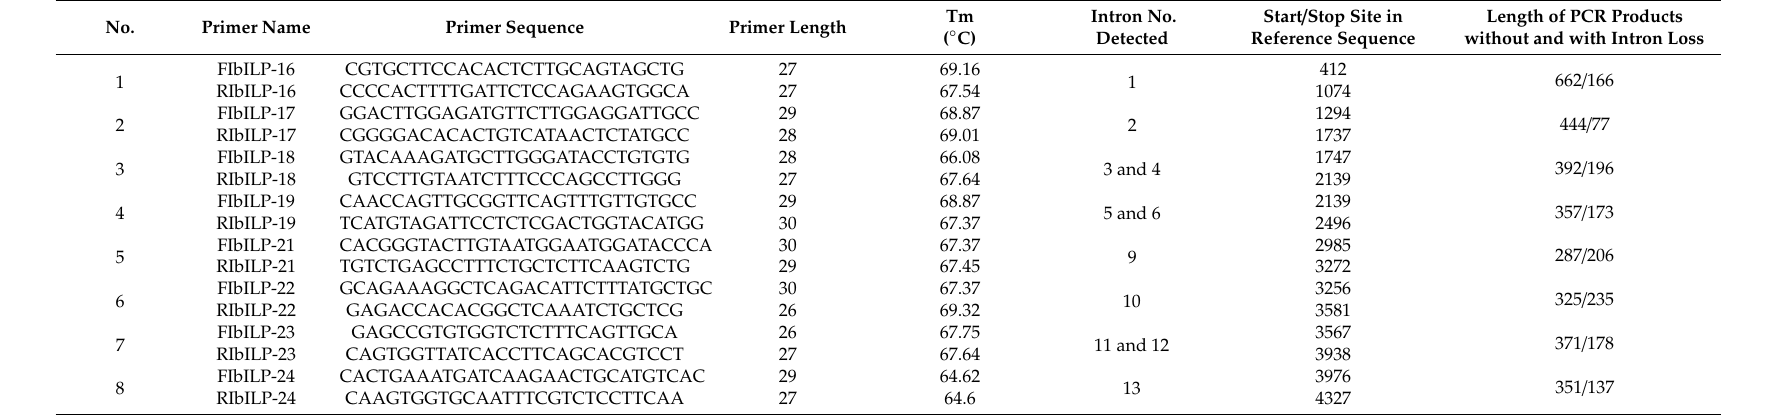
Table 4. Intron length polymorphism (ILP) markers developed based on ILPs detected in IbGBSS1-1